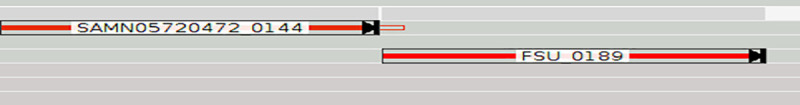
Visual representation for unmatching stop.The registered product with the ID SAMN05720472_0144 predicts a stop ahead compared to the query ORF length. Whereas the product FSU 0189 in the following ORF demonstrates a perfect length match between query and subject, in addition to having a high identity value.